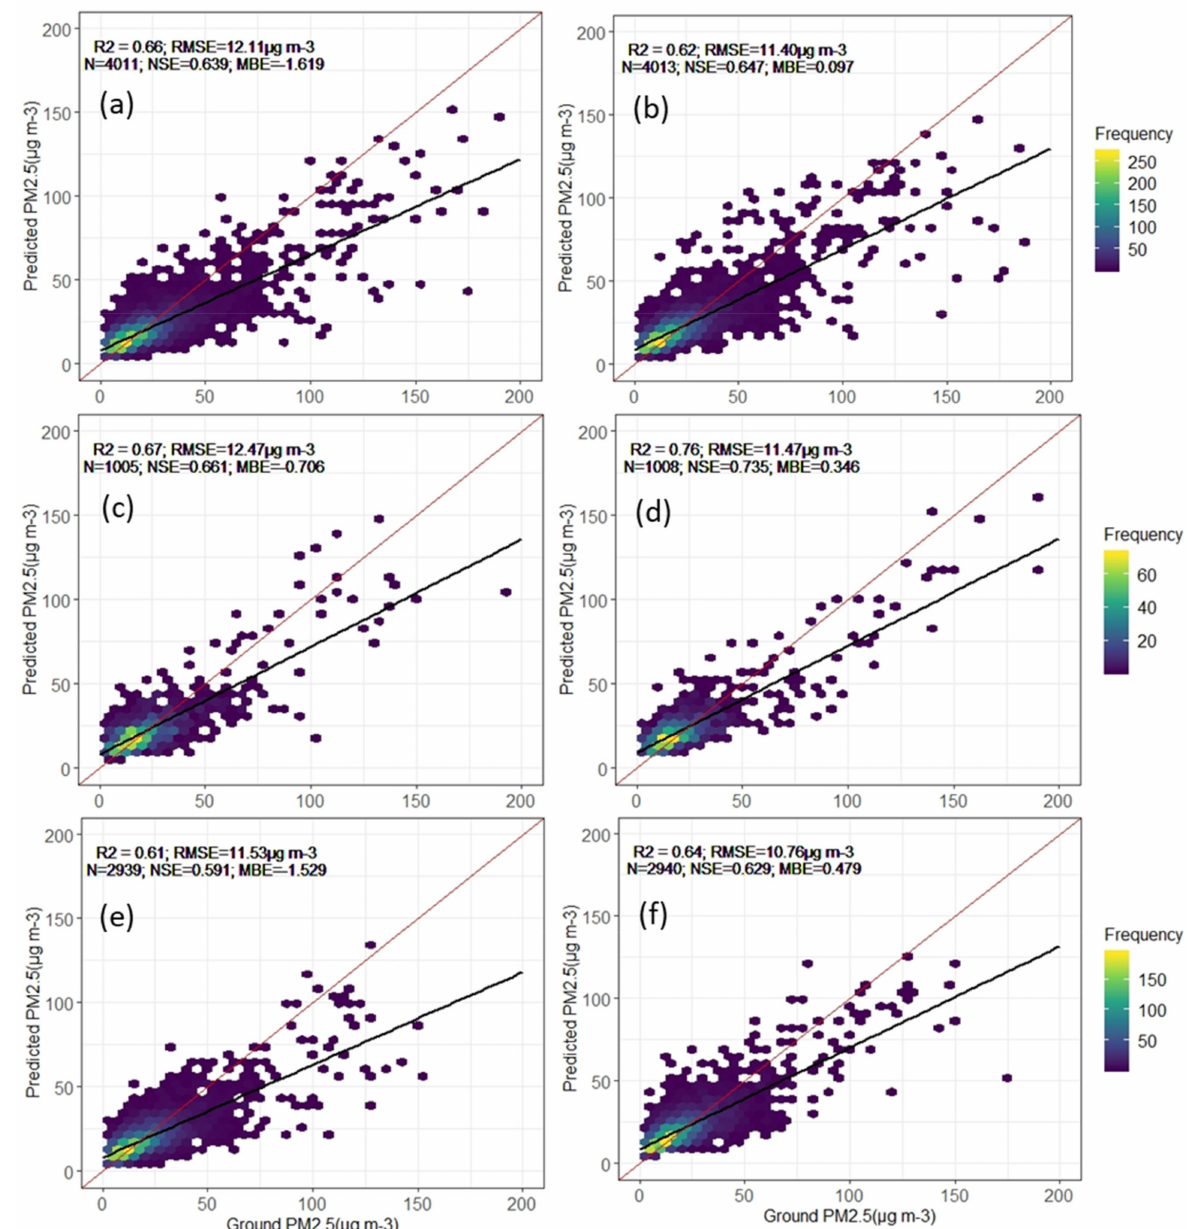
Figure 4. Validation of the predicted PM 2.5 concentrations against measured PM 2.5 using SVR (left) and RF (right) for overall Model 1 ( a , b ), urban/industrial Model 2 ( c , d ), suburban/rural Model 3 ( e , f ). Frequency indicates the density of data/count. The statistical indicators are presented as averaged values in each